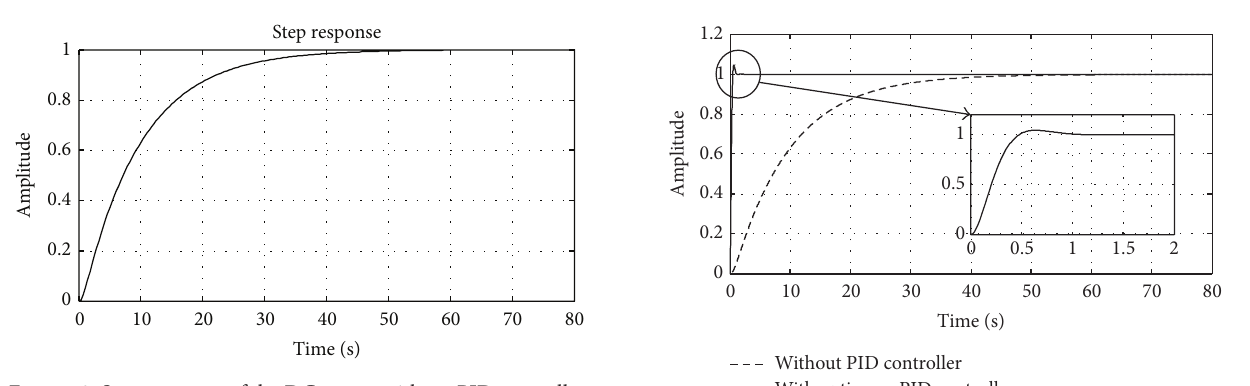
Figure 3: Step response of the DC motor without PID controller.